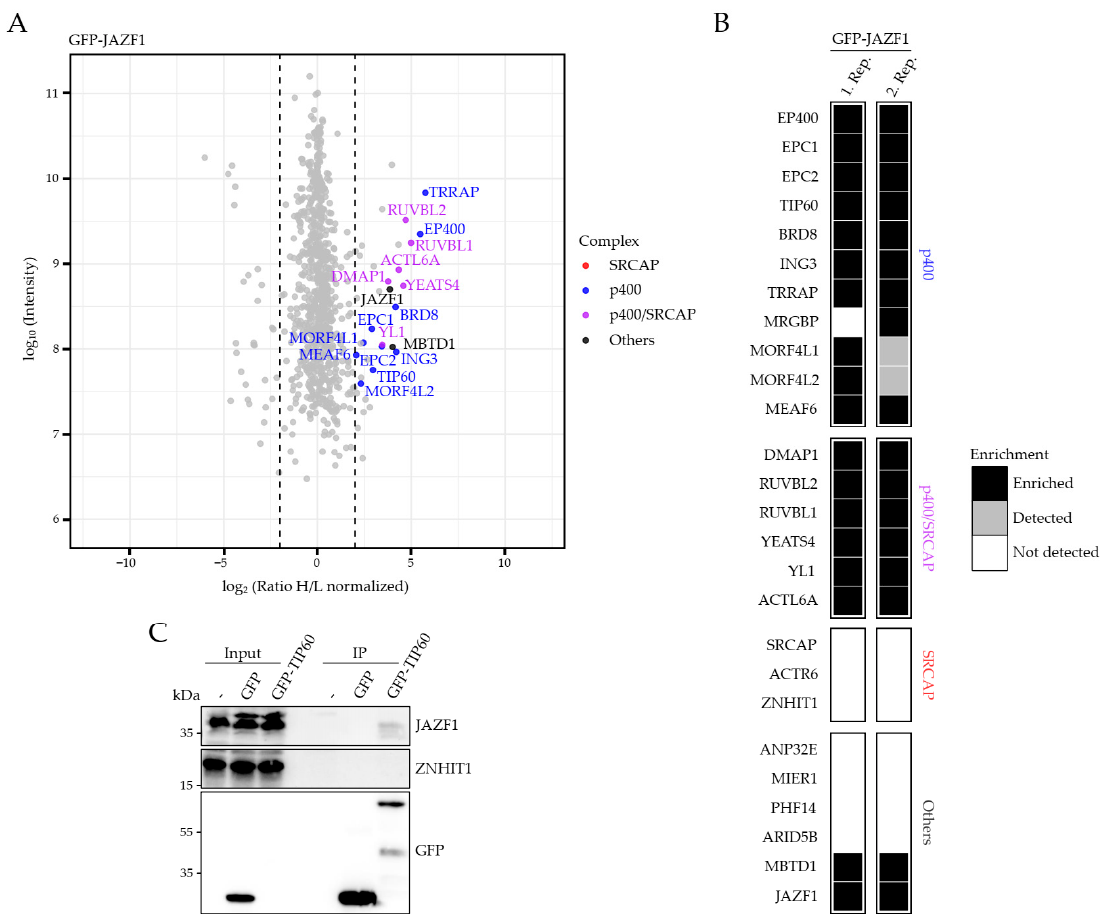
Figure 2. JAZF1 is a member of a TIP60- and MBTD1-containing p400 complex. ( A ) Scatter plot of GFP pull-downs for GFP–JAZF1. HeLa Kyoto cells transiently expressing GFP or GFP–JAZF1 were SILAC-labeled and subjected to single-step affinity purifications of soluble nuclear proteins, using GFP nanotrap beads. In each panel, the ratio of the identified proteins after MS is plotted. Members of the SRCAP complex are depicted in red, members of the p400 complex are in blue and shared members of both complexes are in purple. JAZF1 and MBTD1 are highlighted in black. Dotted lines represent selected ratio cutoff of 4. Shown is one of two biological replicates. See Supplementary Materials Table S1 for a list of all identified proteins. ( B ) Heatmap of p400, SRCAP and shared complex members identified in ( A ) and an additional replicate SILAC experiment. Shown are enriched (black), detected but not enriched (gray) and not detected (white) proteins after MS identifications. Selected ratio cutoff is 4. ( C ) Immunoblotting of JAZF1, SRCAP member ZNHIT1 and GFP upon transient transfection of HeLa Kyoto cells with GFP and GFP–TIP60, followed by GFP-trap pull-downs of soluble nuclear extracts.